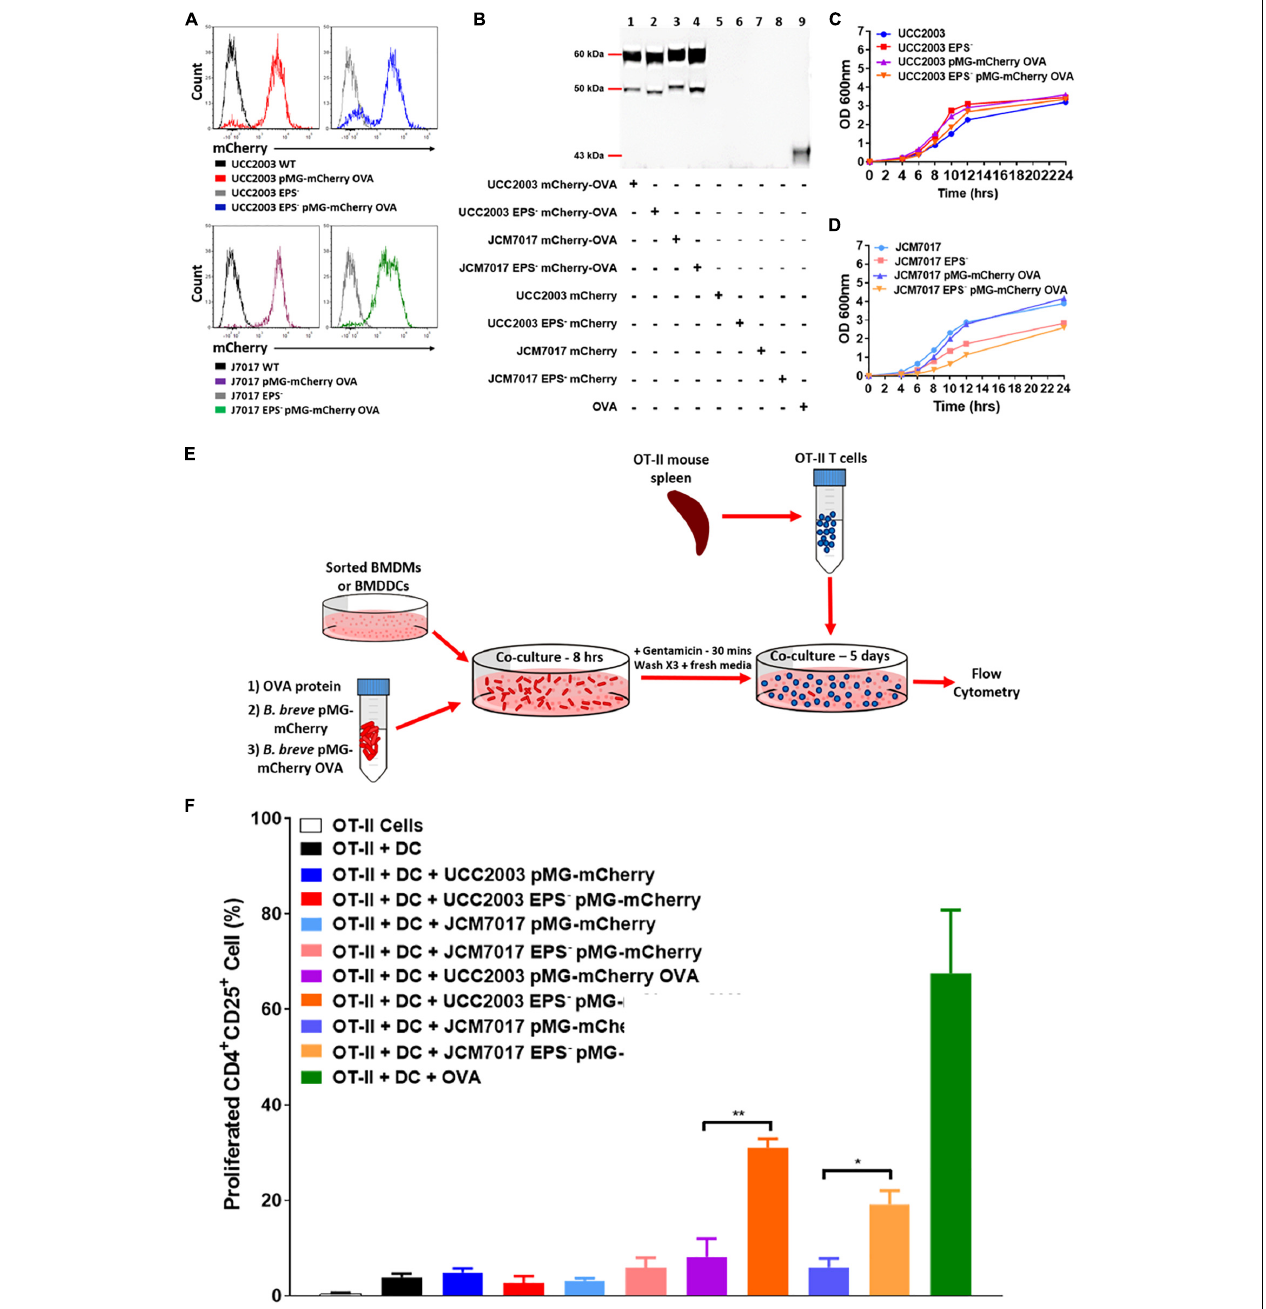
FIGURE 6 | EPS protects from antigen presentation of B. breve to OT-II CD4 + T cells by DCs. (A) mCherry expression (pMG-mCherry OVA) in the indicated B. breve strains by flow cytometry. Histograms were obtained by gating on bacterial cells. Black and gray histograms were obtained from parental B. breve UCC2003 and JCM7017 wild type or EPS − . Red and blue histograms were obtained from B. breve UCC2003 wt and B. breve UCC2003 EPS − transformed with the plasmid pMG-mCherry OVA. Purple and green histograms were obtained from B. breve JCM7017 wt and B. breve JCM7017 EPS − transformed with the plasmid pMG-mCherry OVA. (B) Western blot for OVA protein production by pMG-mCherry-OVA and pMG-mCherry transformed strains of B. breve as indicated. 0.025 µ g of ovalbumin was used as a positive control. (C,D) Growth curves of strains transformed or untransformed with the pMG-mCherry-OVA plasmid over 24 h. Growth curves are representative of three experiments. (E) Schematic of the antigen presentation assay setup. (F) Sorted BMDCs were co-cultured or not with different bacterial strains expressing or not OVA (as indicated) for 8 h. OVA protein was used as positive control. mCherry only expressing bacteria were used as negative controls. Cells were then co-cultured with OT-II CD4 + T cells for 5 days and analyzed by multi-color flow cytometry. T cells were stained for CD4, CD25, and CFSE. Percentage of proliferated CD4 + CD25 + OT-II T cells was quantitated and presented as mean ± SEM. Data is the average of three independent experiments performed in triplicate wells. Statistical analysis was assessed using the student t -test in GraphPad Prism where * p -value < 0.05 and ** p -value < 0.005.